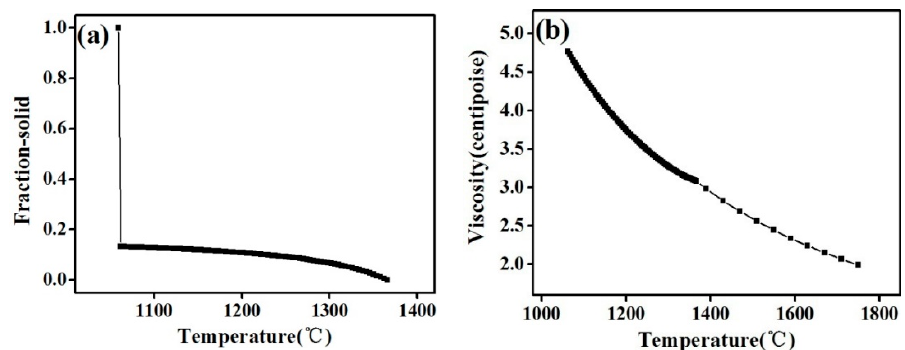
Figure 12. Calculated values of Cu ‐ 14Fe alloy thermophysical parameters. ( a ) Solid Fraction ‐ Temperature curve and ( b ) Viscosity ‐ Temperature curve.